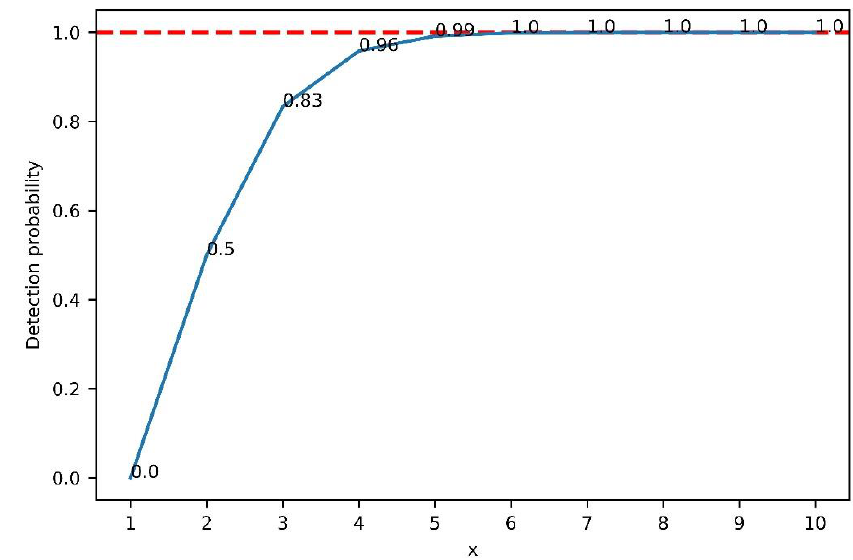
Figure 2. Detection probability of the intercept and resend attack.